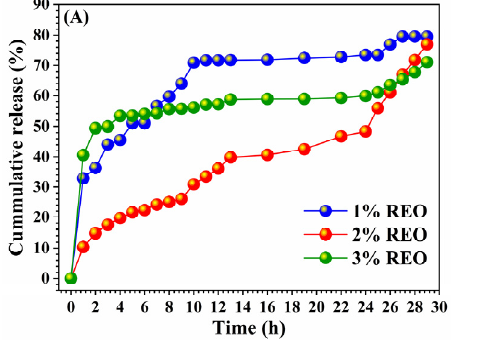
Figure 7. Kinetical release profiles of rosemary essential oil from CA-REO ( A ) and hybrid CA-MTN- REO ( B ) microcapsules in w/o medium .